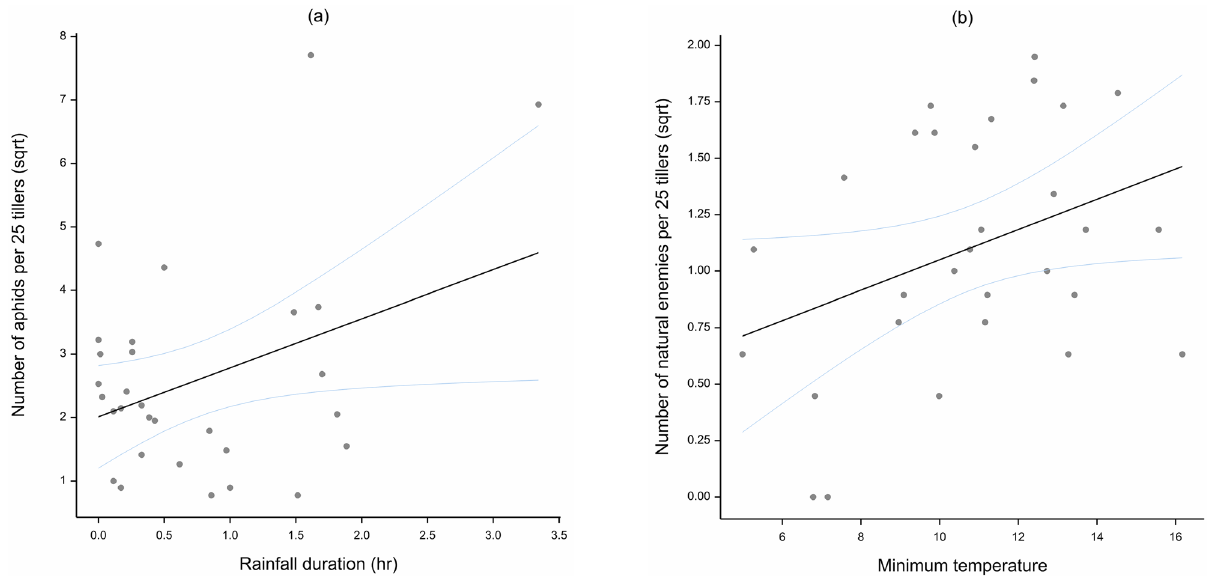
Figure 7. Correlation between ( a ) number of aphids per 25 tillers and rainfall duration (r) ( b ) number of natural enemies per 25 tillers and minimum temperature. The number of aphids and natural enemies per 25 tillers was subject to square root